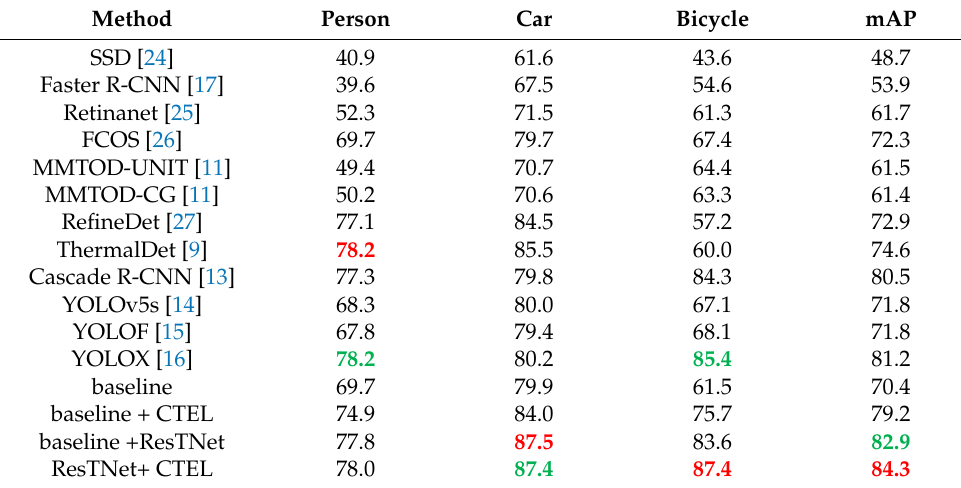
Table 2. This is the performance of various advanced methods on FLIR dataset. Top2 is highlighted using red and green, respectively. Method